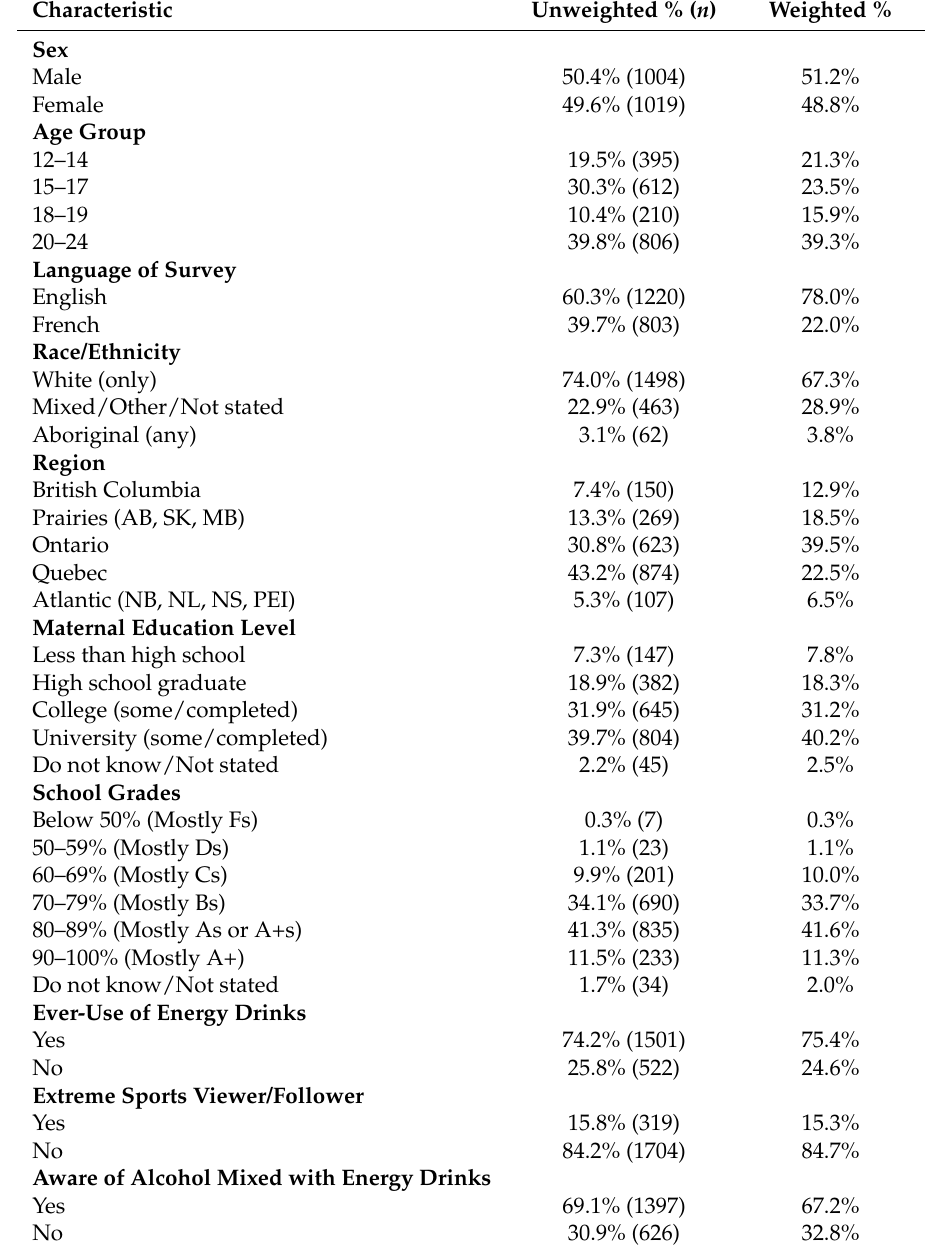
Table 1. Sample characteristics of respondents in analytic sample, unweighted and weighted ( n =